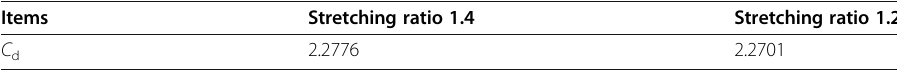
Table 2 Drag coefficient calculated from different stretching ratios Items